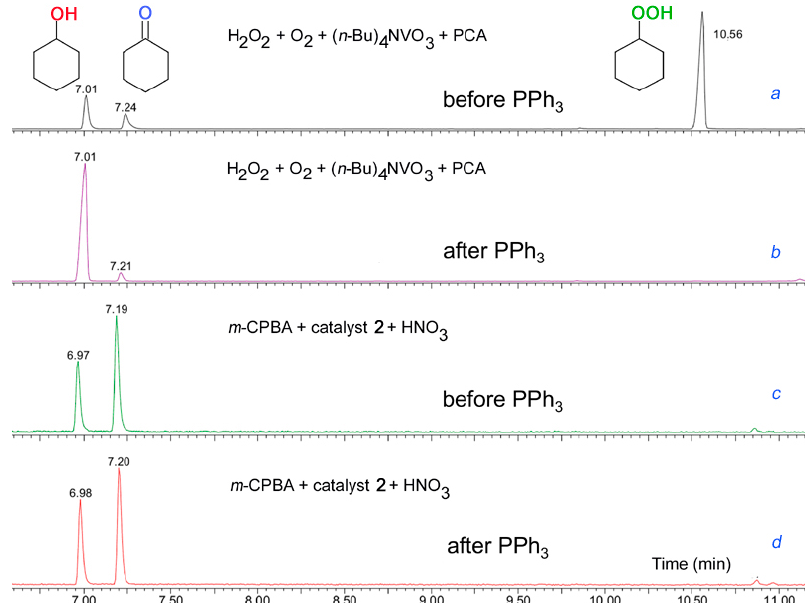
Figure 17. Chromatograms of reaction products obtained in the cyclohexane oxidation in acetonitrile by the H 2 O 2 /O 2 /vanadate anion/PCA reagent [78–92] and the m ‐ CPBA/catalyst 2 /HNO 3 system (see below [160]). For both systems the chromatograms were recorded before and after the addition of PPh 3 . Conditions: [cyclohexane] 0 = 0.46 M; ( a and b ): [H 2 O 2 ] 0 = 0.75 M, [( n ‐ Bu) 4 NVO 3 ] 0 = 1 × 10 − 4 M, [PCA] 0 = 4 × 10 − 4 M, 40 °C; ( c and d ): [ m ‐ CPBA] 0 = 0.028 M, [complex 2 ] 0 = 2.7 × 10 − 6 M, [HNO 3 ] 0 = 5.5 × 10 − 3 M, 50 °C. A Perkin ‐ Elmer Clarus 600 gas chromatograph, equipped with non ‐ polar capillary columns (SGE BPX5; 30 m × 0.32 mm × 25 μ m) was used for analyses of the reaction mixtures. Adapted from Ref. [160].